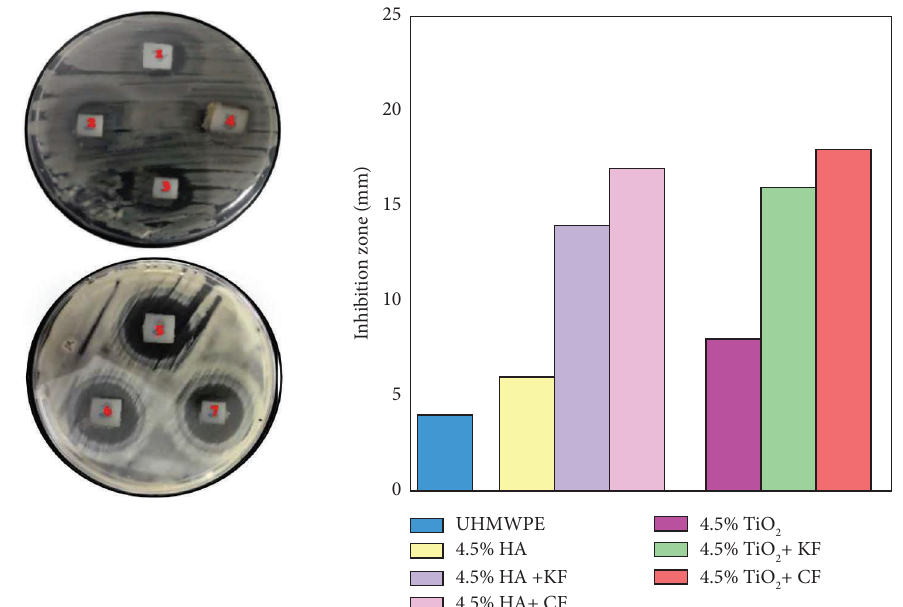
Figure 5: Inhibition zone of the n-HA and n-TiO 2 particulate and hybrid biocomposites against S. aureus bacteria.